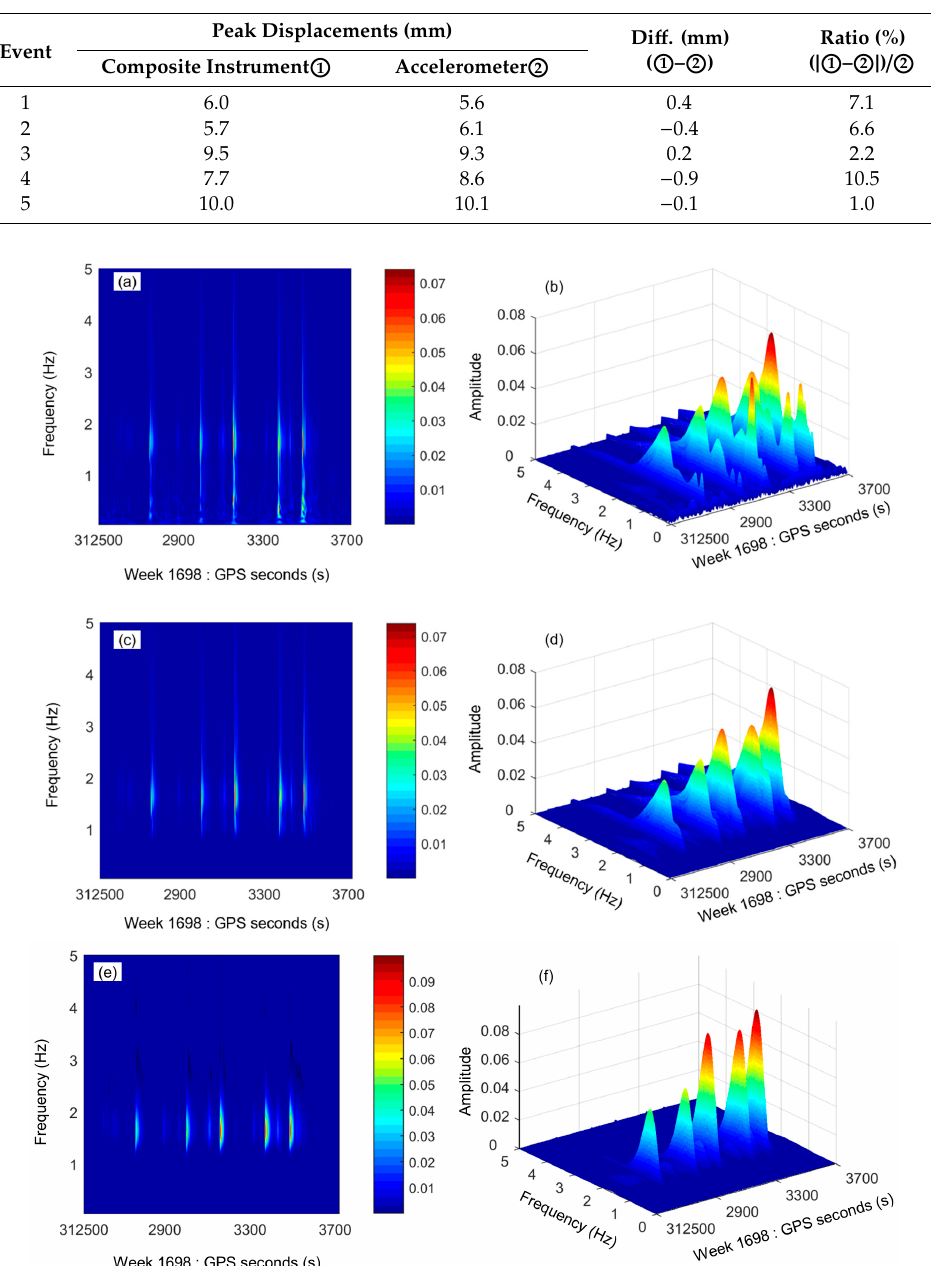
Table 3. Comparison of peak values of two sets of dynamic displacement in the vertical direction derived from the composite instrument and accelerometer measurements in Case 2.